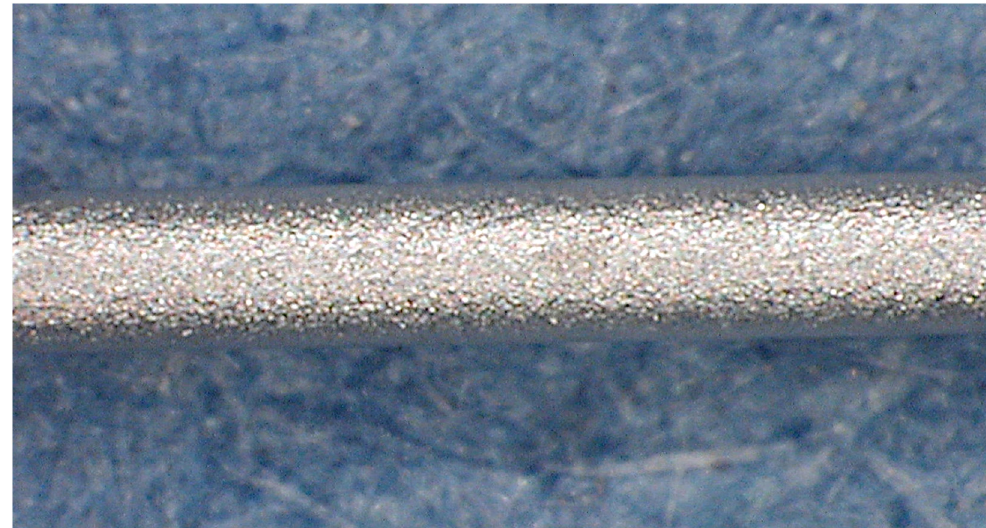
Sensors 2022 , 22 , x FOR PEER REVIEW